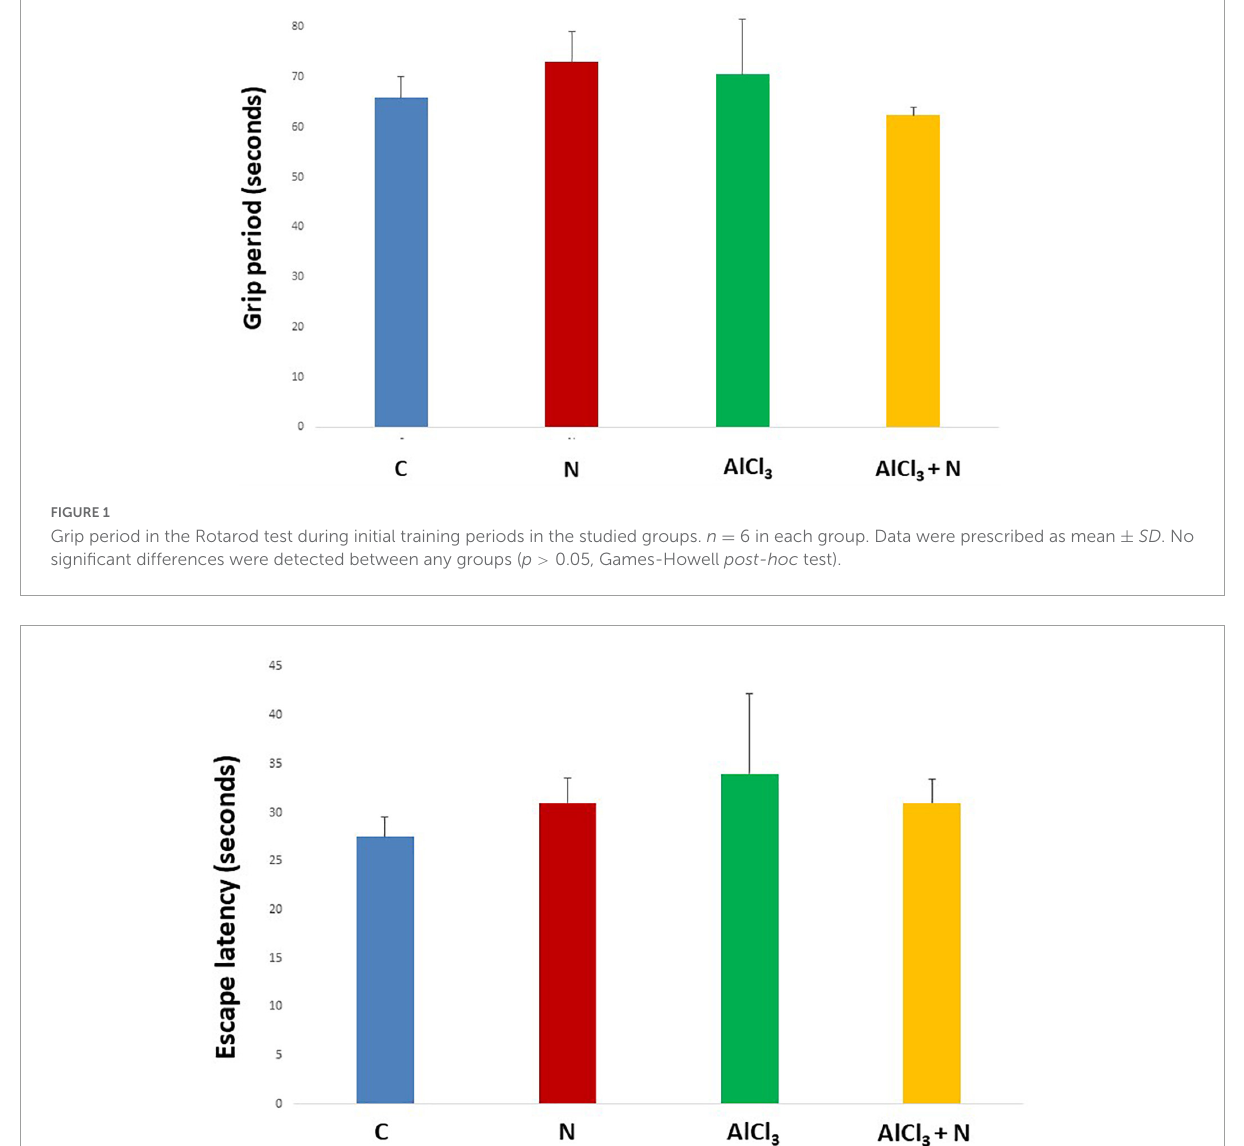
FIGURE2 Escape latency in the Morris water maze test during initial training periods in the studied groups. n = 6 in each group. Data were prescribed as mean ± SD . No significant differences were detected between any groups ( p > 0.05, Games-Howell post-hoc